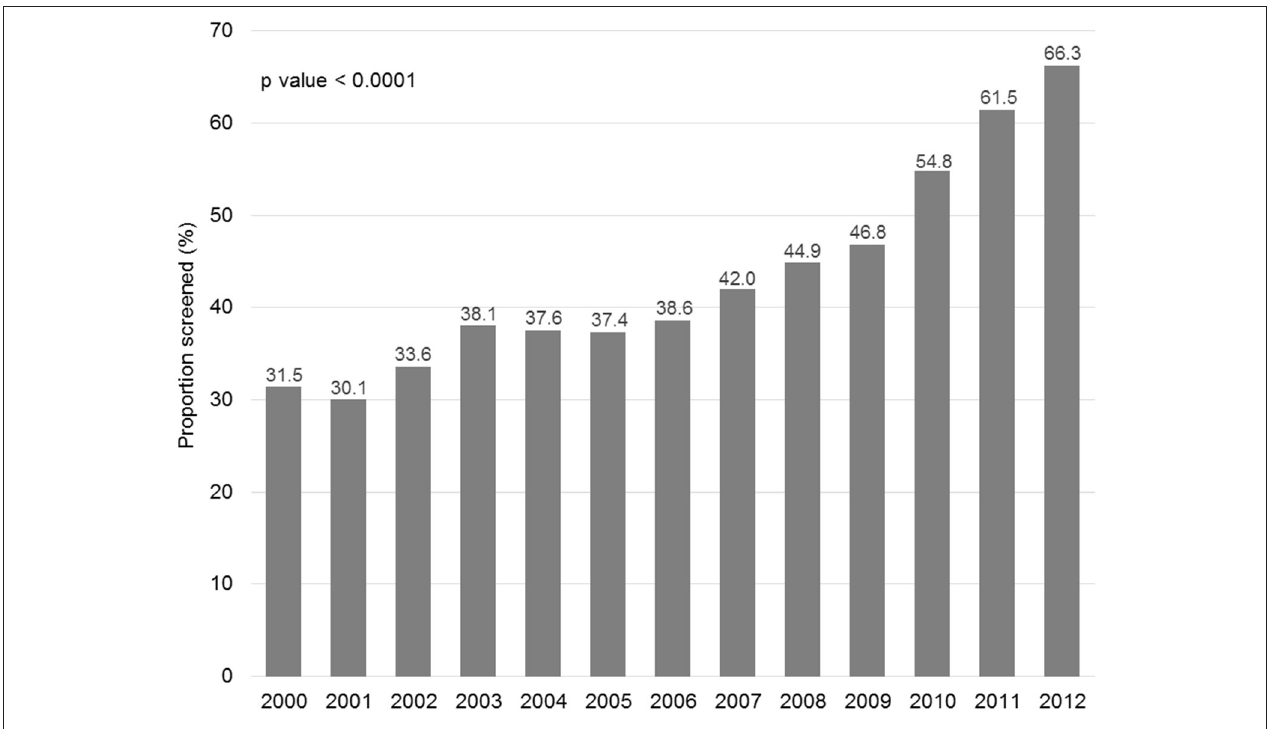
FIGURE 1 | Changes in the annual HBV screening